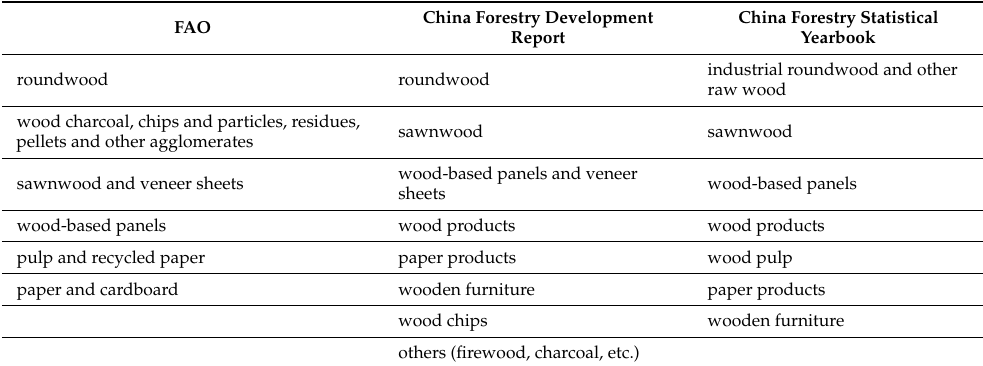
Table 1. Classification of wood forest